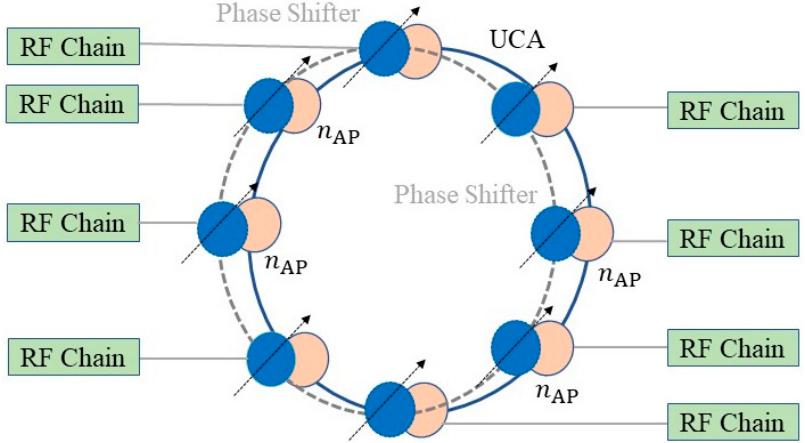
Figure 2. Digital beamformer at mmWave fog APs.